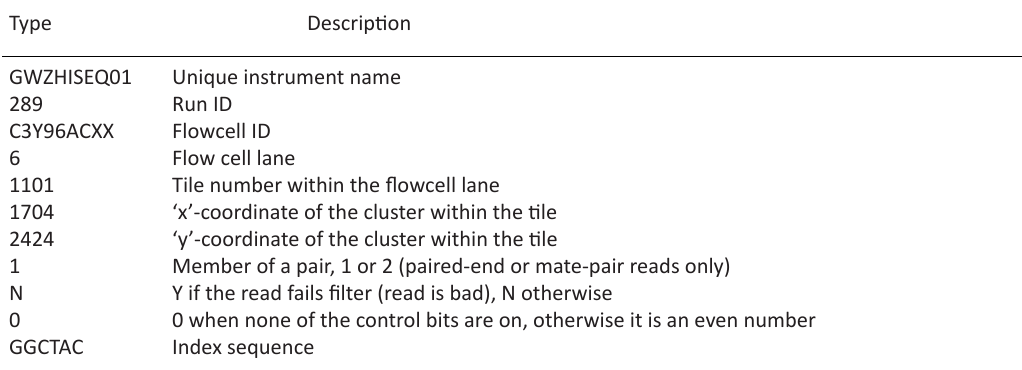
Table 1. Explanation of the elements in sequence identifiers